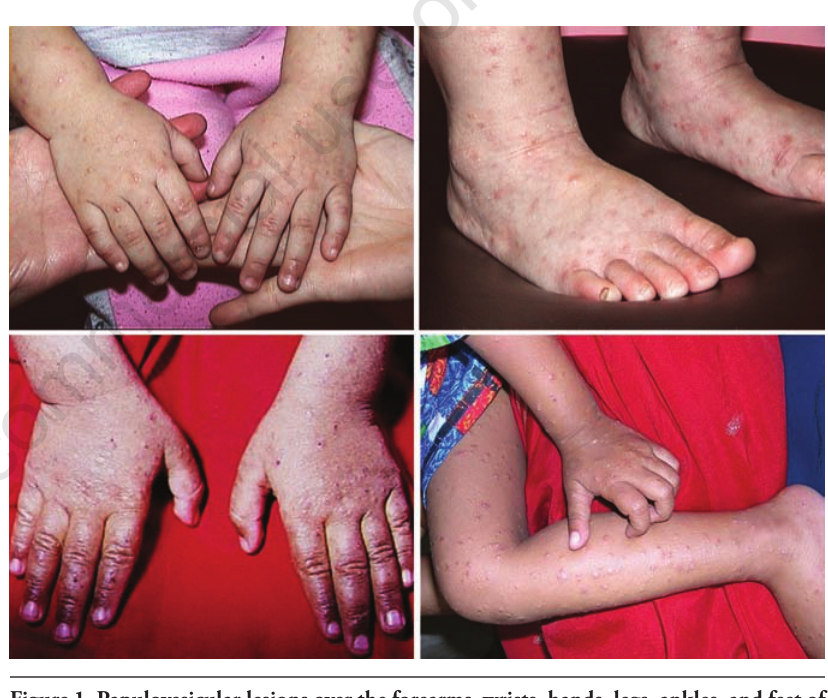
Figure 1. Papulovesicular lesions over the forearms, wrists, hands, legs, ankles, and feet of a Chinese child with Gianotti-Crosti syndrome (papular acrodermatitis of childhood).